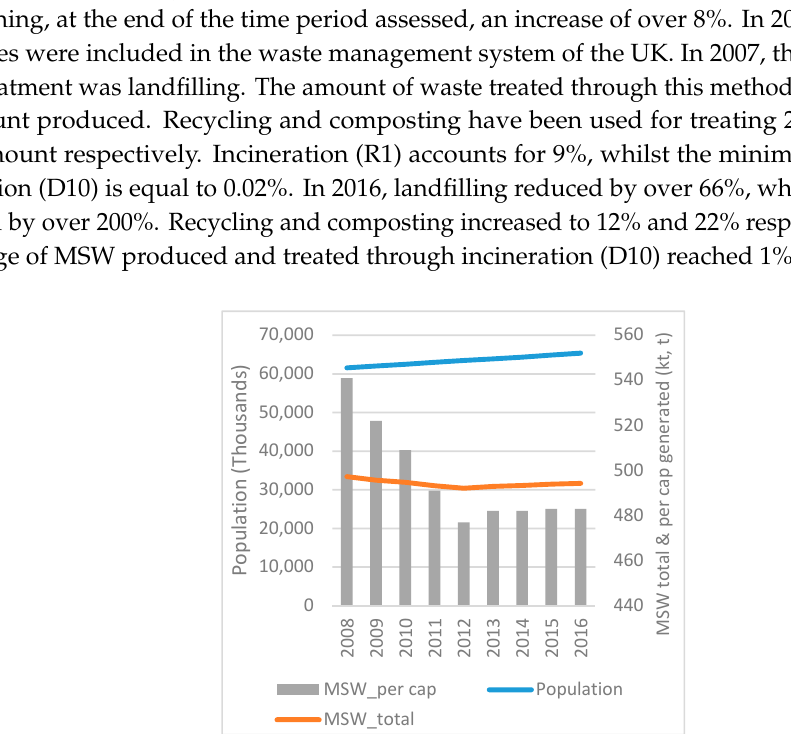
Figure 54. Waste treatment methods and PPP in Sweden 2008–2017 (EUROSTAT 2019b, 2019c).